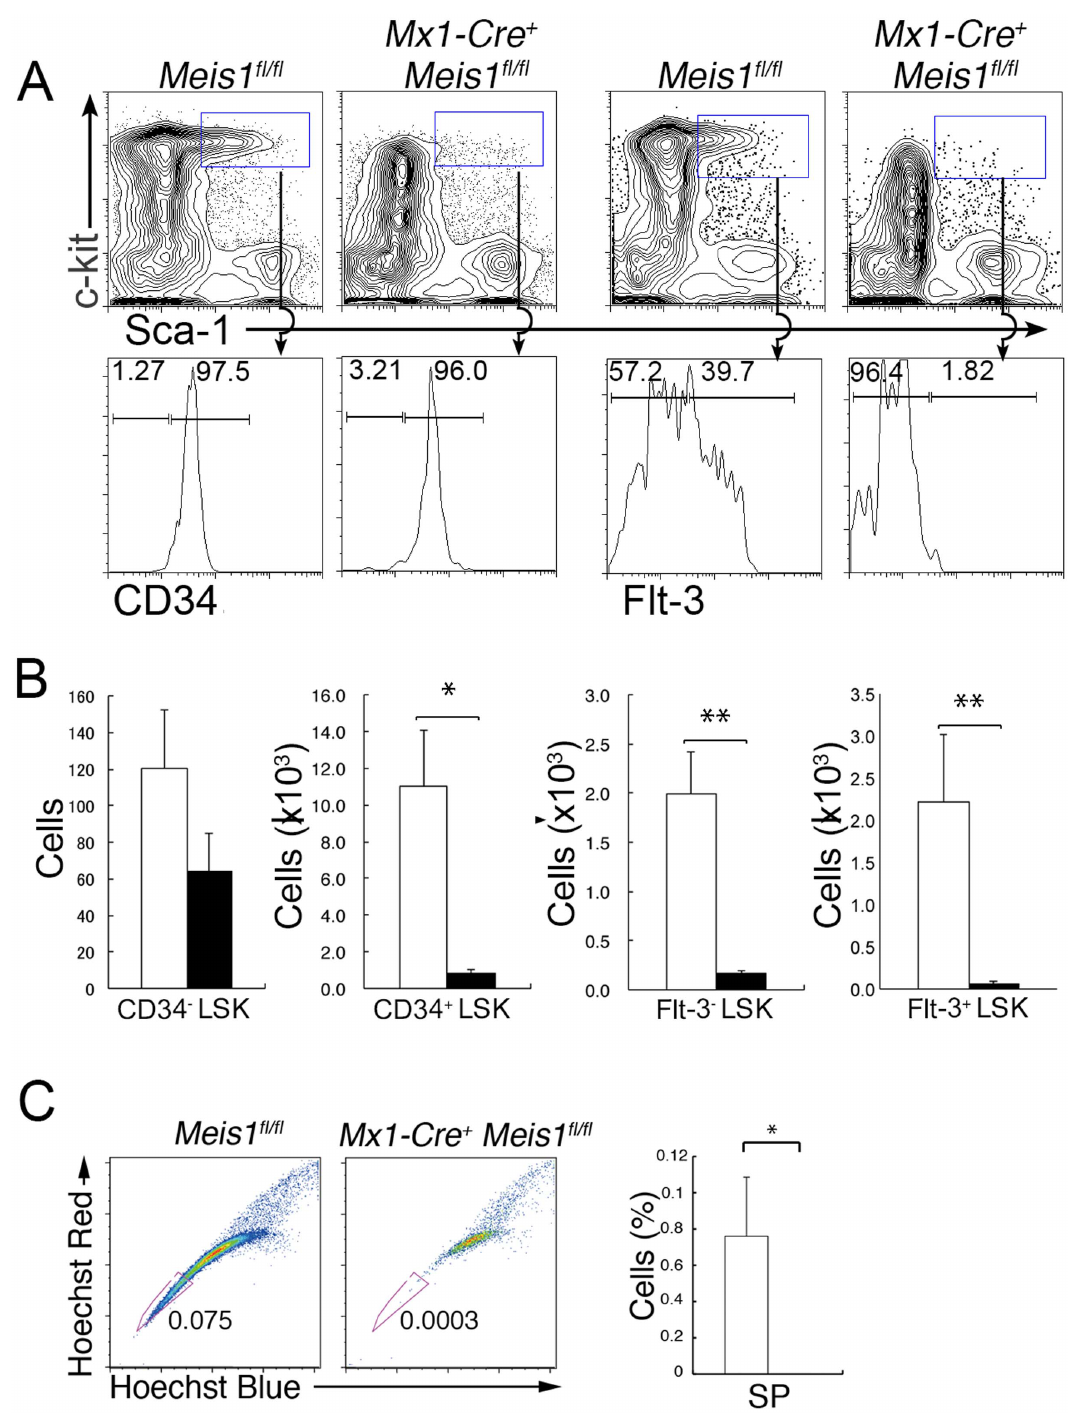
Figure 2. Loss of Meis1 causes profound defects in the HSC compartment. (A) Representative flow cytometric profiles of LSK cells in BM depleted of lineage-positive cells from Mx1-Cre + Meis1 fl/fl and control Meis1 fl/fl mice three weeks after poly(I:C) treatment. Gates used to identify LSK cell populations are outlined, and downward arrows indicate their relationship to subsequent histograms showing the expression of CD34 or Flt3 in these cell populations. Numbers in the histograms indicate percent events in each gate. (B) Absolute numbers of the indicated LSK cell populations per two femurs from poly(I:C)–treated Mx1-Cre + Meis1 fl/fl (solid bars) and control Meis1 fl/fl (open bars) mice (mean and SD; n=4). *p , 0.05 and **p , 0.01. (C) Representative flow cytometric profiles of side population (SP) cells within the LSK population from Mx1-Cre + Meis1 fl/fl and control mice one week after poly(I:C) treatment. Bar graphs shown on the right represent the percentage of SP cells in the LSK cell population from poly(I:C)– treated Mx1-Cre + Meis1 fl/fl (solid bars) and control Meis1 fl/fl (open bars) mice (mean and SD; n=3). *p , 0.005.